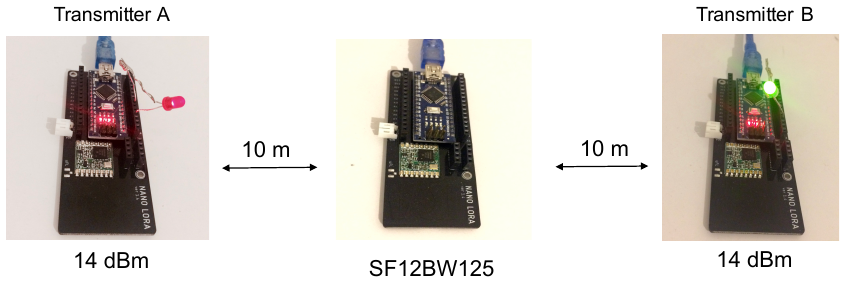
Figure 6. First CE experimentation